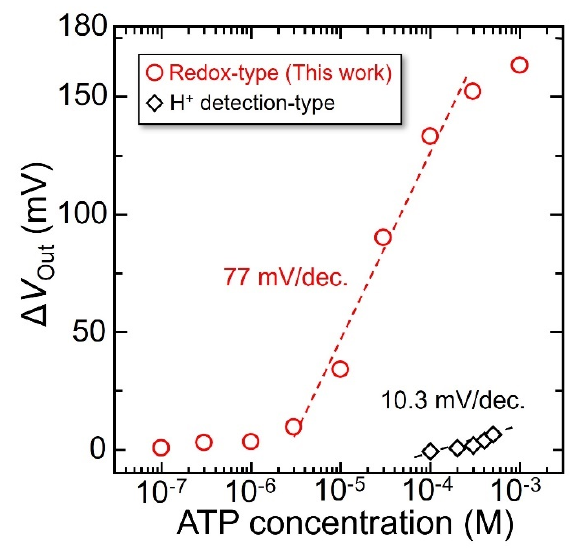
Figure 10. Concentration dependence of enzyme-immobilized sensor on ATP concentration. Working buffer is 10 mM − HEPES, at pH7.4.